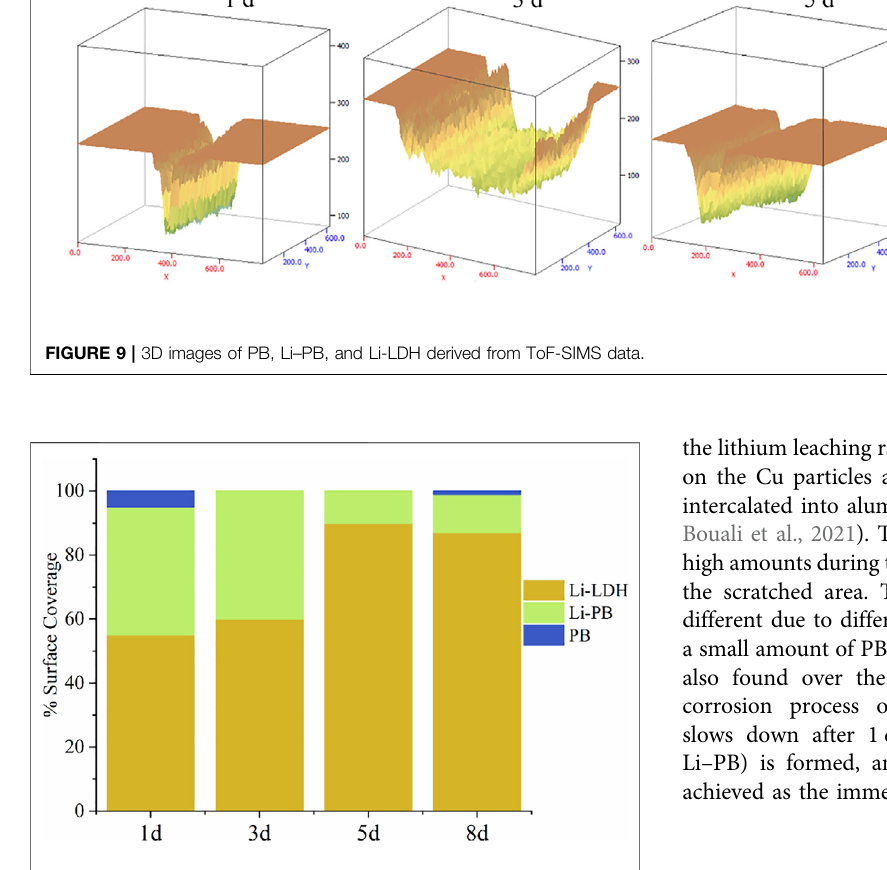
Frontiers in Materials |